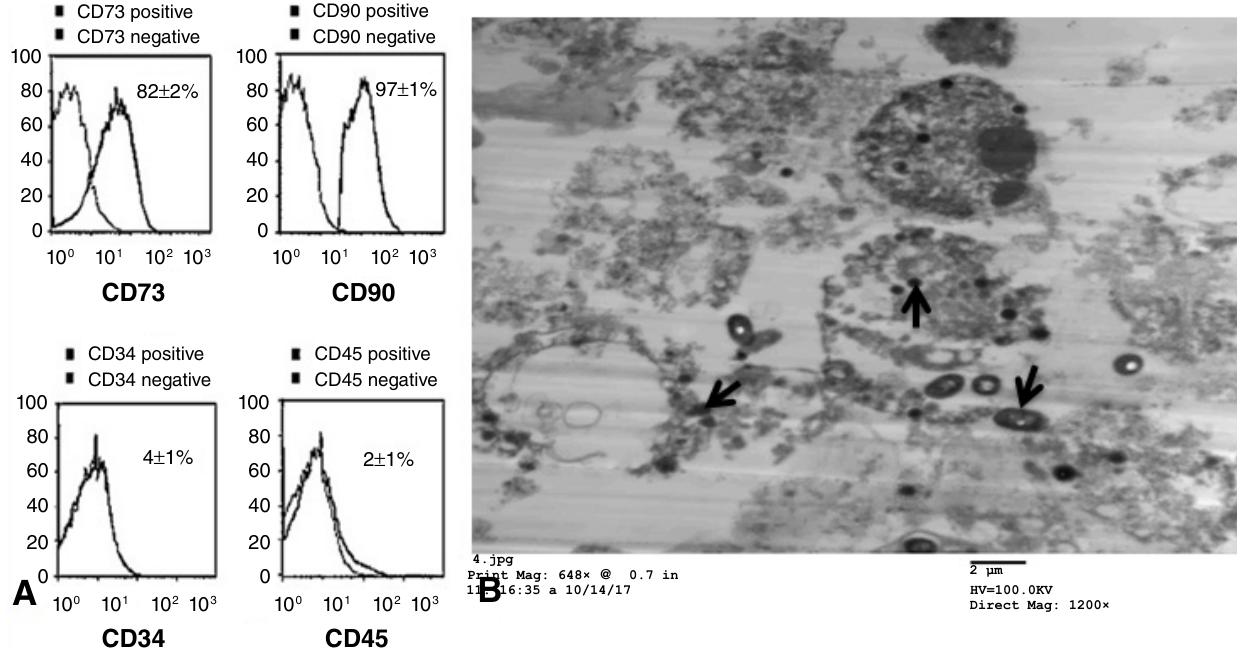
Figure 2. Flow cytometry and transmission electron microscopy. ( A ) Flow cytometry analysis of CD90, CD73, CD34 and CD45 for stem cell characterization. ( B ) Electron microscopy ultrastructure of released microvesicles (black arrow) from the mesenchymal stem cells of dental